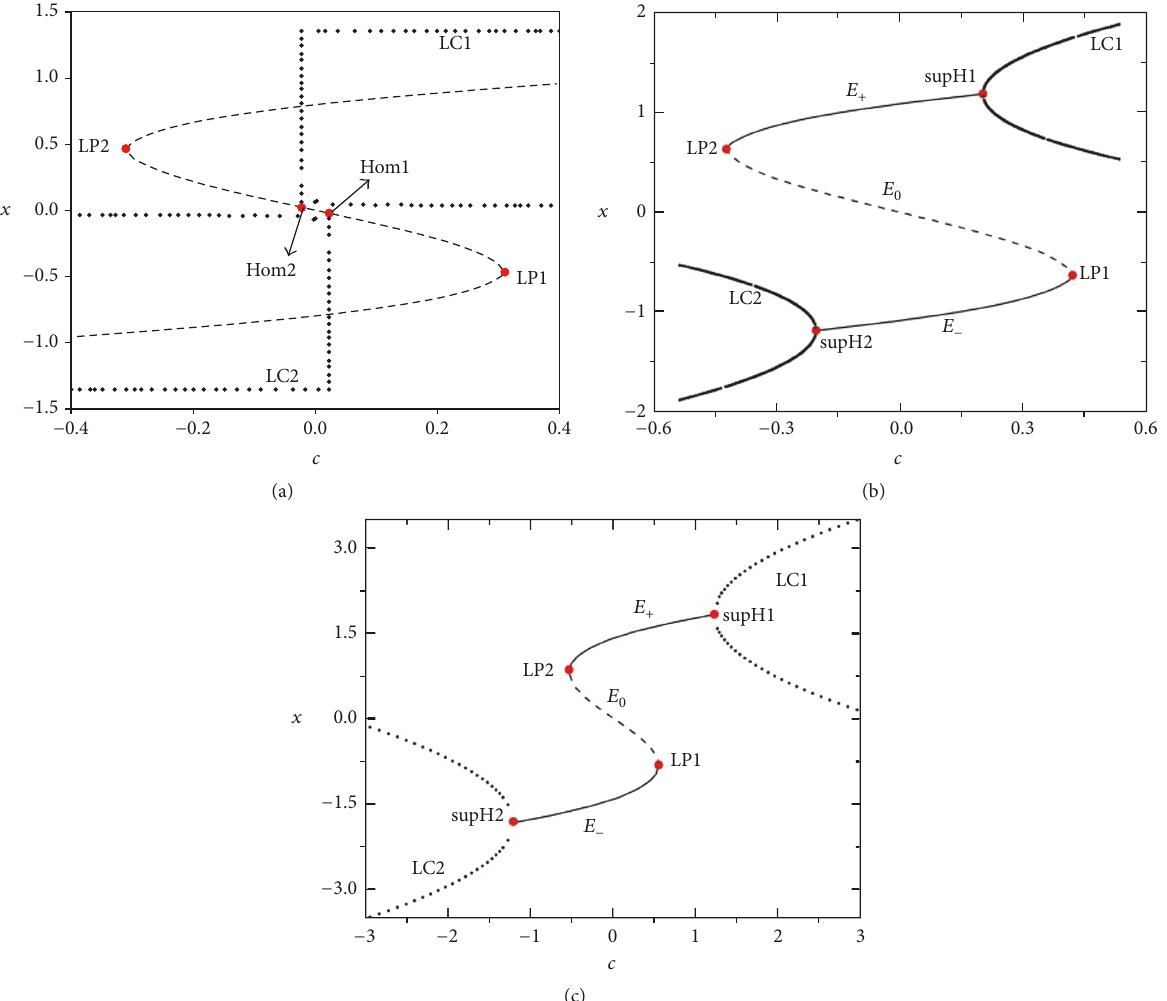
Figure 2: Bifurcation diagrams for (a) 𝑏 = 0.65 ; (b) 𝑏 = 1.2 ; and (c) 𝑏 = 2 . The solid line represents the stable parts; the dashed line represents the unstable parts; e represents the stable limit cycles; Hom1 and Hom2 represent the two homoclinic bifurcation points; LP1 and LP2 represent the twofold bifurcation points; supH1 and supH2 represent the two Hopf bifurcation points; LC1 and LC2 represent the two stable limit cycles; and 𝐸 + , 𝐸 − , and 𝐸 0 represent the equilibrium branch of the generalized autonomous system.